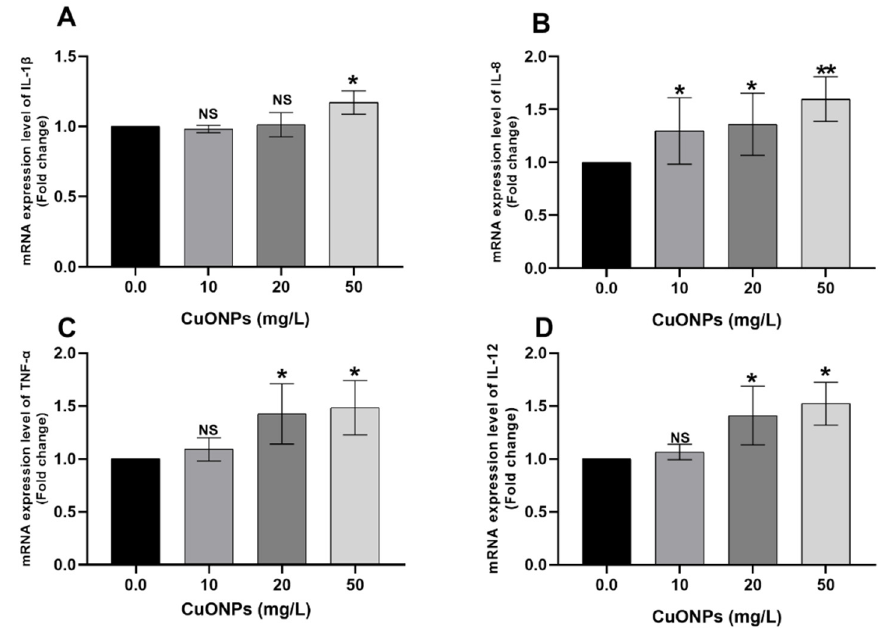
Figure 1. mRNA transcription profile of the pro-inflammatory cytokine genes including IL-1 β ( A ), IL-8 ( B ), TNF- α ( C ), and IL-12 ( D ) in the gills of Nile tilapia juveniles after exposure to sub-lethal concentrations of CuONPs (0.0 mg/L, 10 mg/L, 20 mg/L and 50 mg/L) for 25 days. The values are expressed as mean ± SEM ( n = 9). Asterisk (*) ( p < 0.05) and (**) ( p < 0.01) indicates significant differences between the exposure groups compared with the control group. NS indicates non-significant differences.